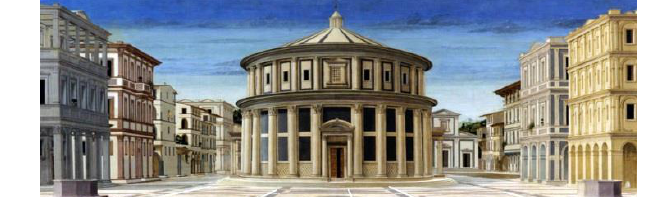
Fig. 12 The ideal city (Anonymous, 1490)